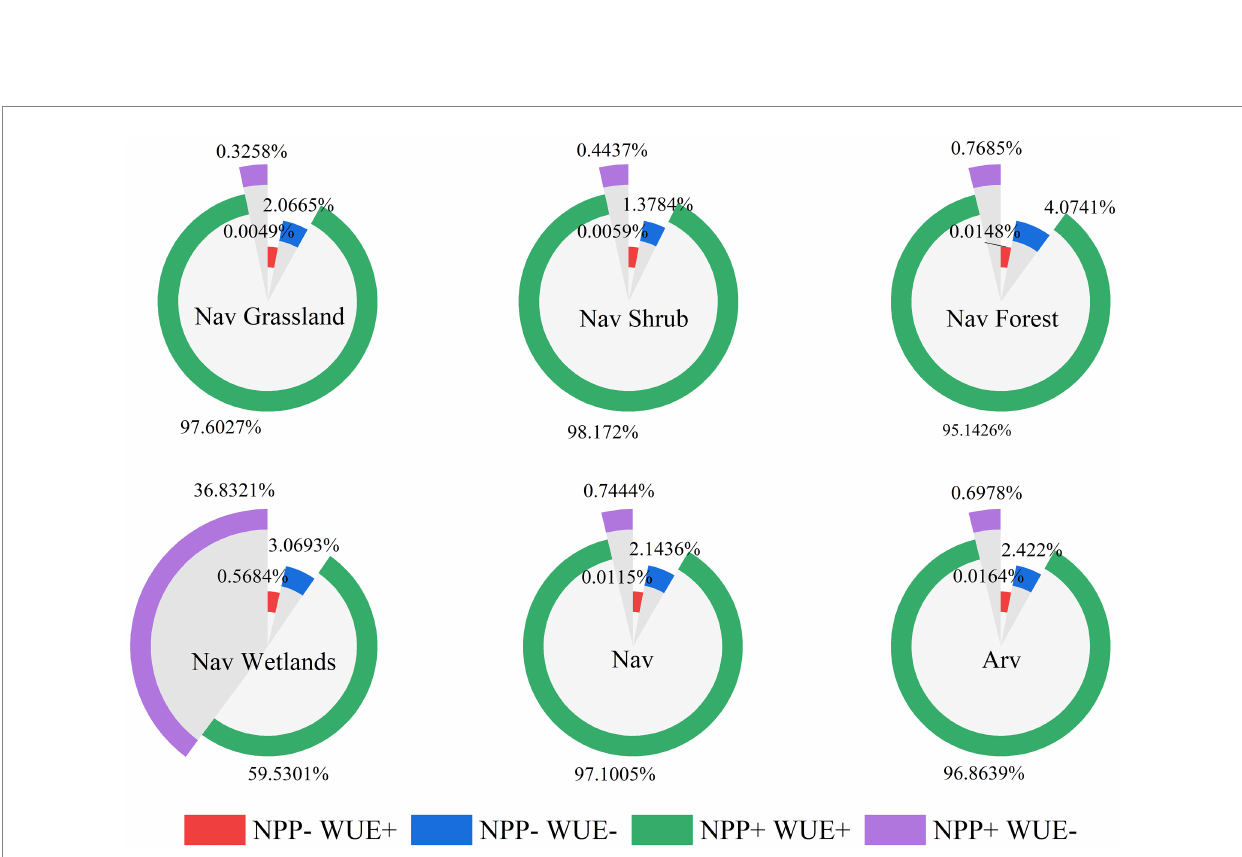
FIGURE 7 Percentage contribution of each vegetation type at different stages of degradation and